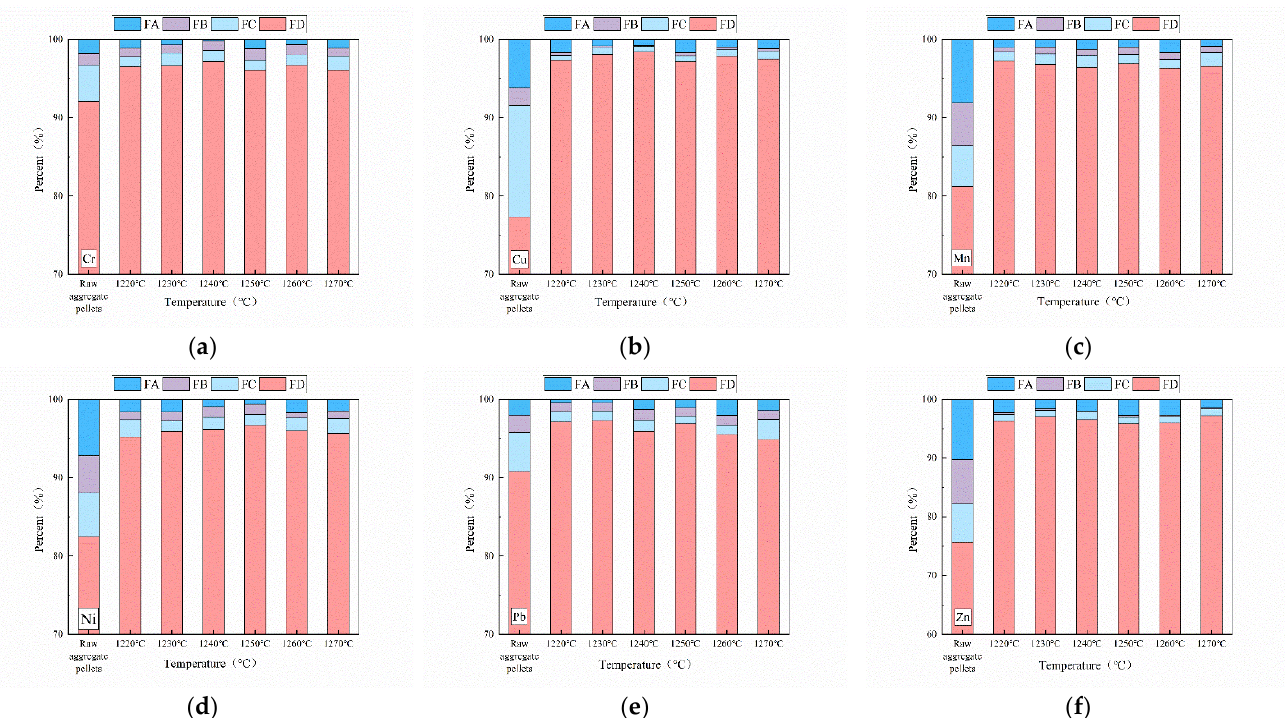
Figure 9. Morphological occurrence of heavy metals at different sintering temperatures: ( a ) 1220 °C, ( b ) 1230 °C, ( c ) 1240 °C, ( d ) 1250 °C, ( e ) 1260 °C, ( f ) 1270 °C.